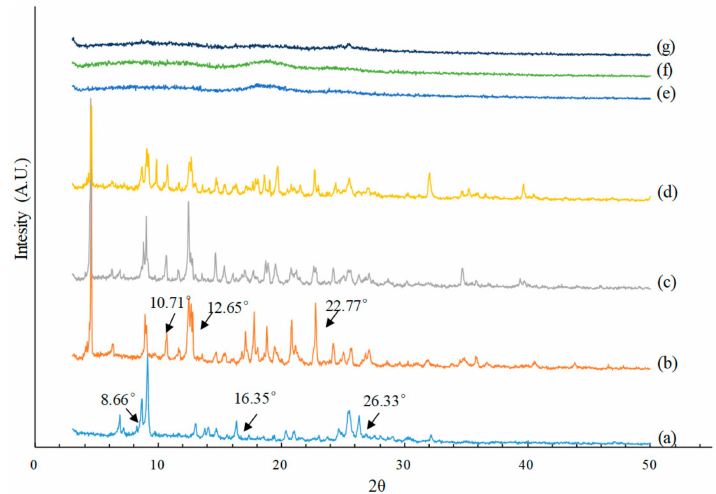
Figure 5. X-ray diffraction patterns of ( a ) BBR; ( b ) raw β -cyclodextrin; ( c ) physical mixture (1:1, n / n ); ( d ) ICB; ( e ) BP m Sample 7; ( f ) BP n Sample 2; ( g ) BP mix Sample 4.